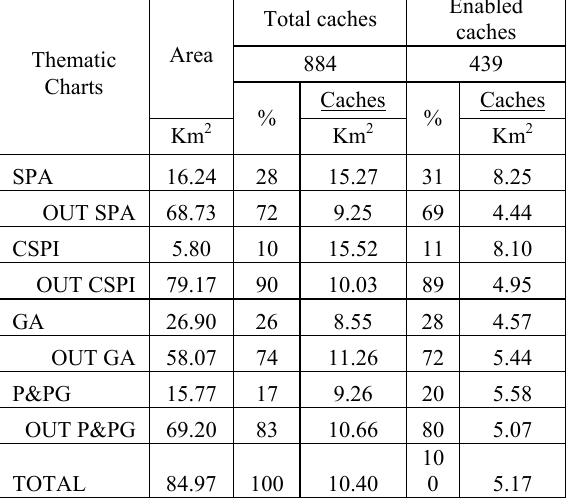
Table 2. Total Area, Caches numbers and densities of each Lisbon thematic charts used in the spatial dataset analyses. SPA = Special Protection Areas; CSPI = City Sites of Public Interest; GA = Green Areas; P&PG = Parks & Public Gardens.